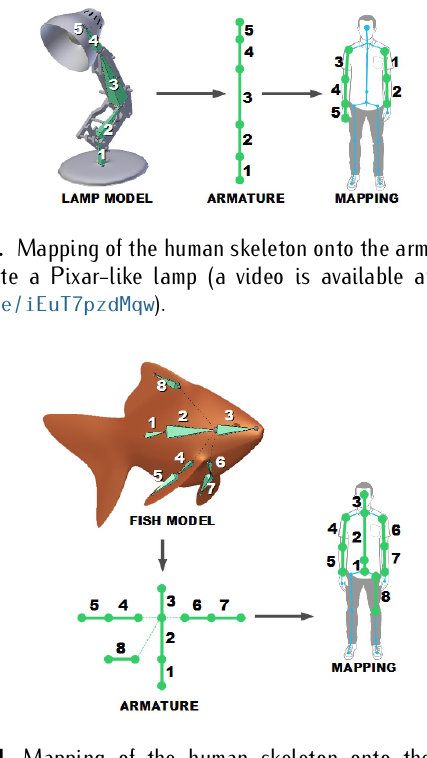
Figure 4. Mapping of the human skeleton onto the armature used to animate a fish (a video is available at http://youtu. be/v1mMtAgFhzQ ).